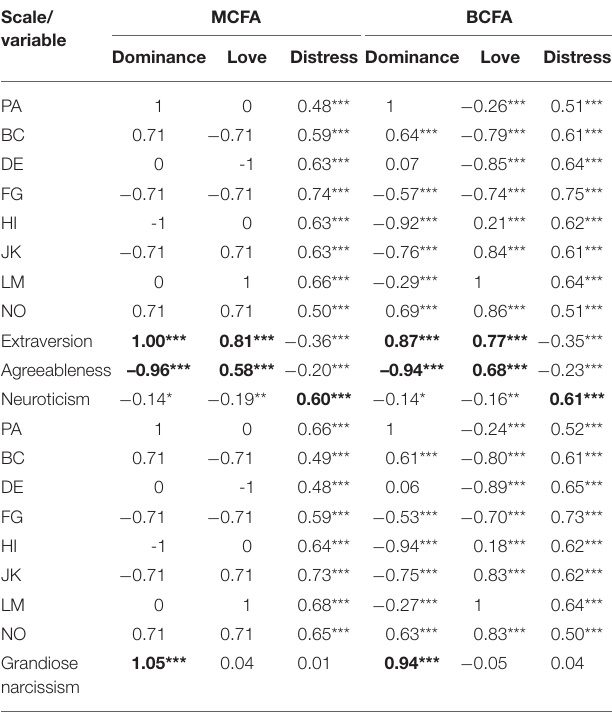
TABLE 3 | Confirmatory factor analysis of the inventory of interpersonal problems with external measures. Scale/ variable